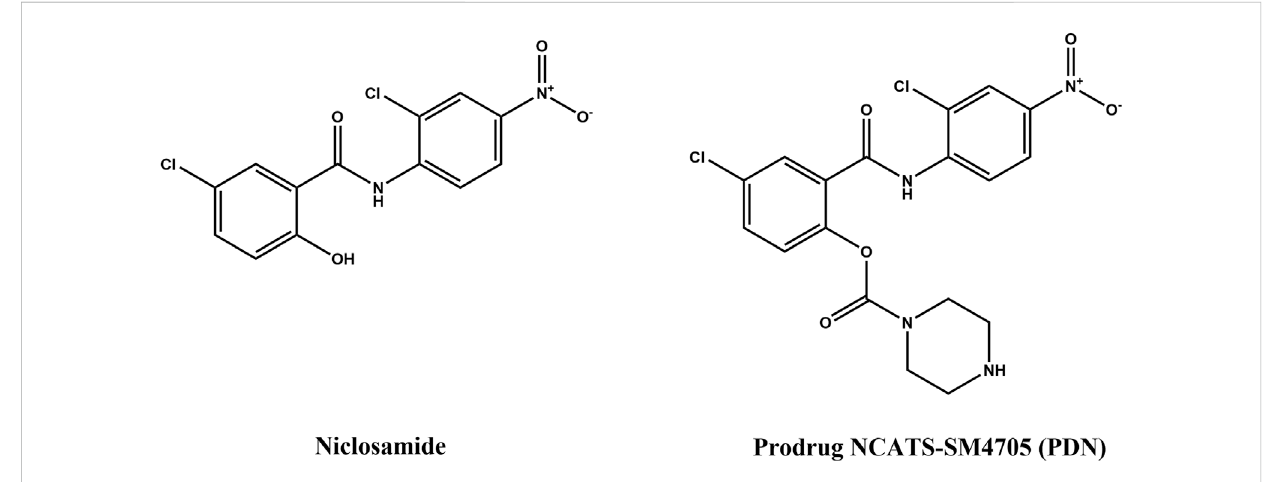
FIGURE 1 Structures of niclosamide (Nc) and its prodrug NCATS-SM4705